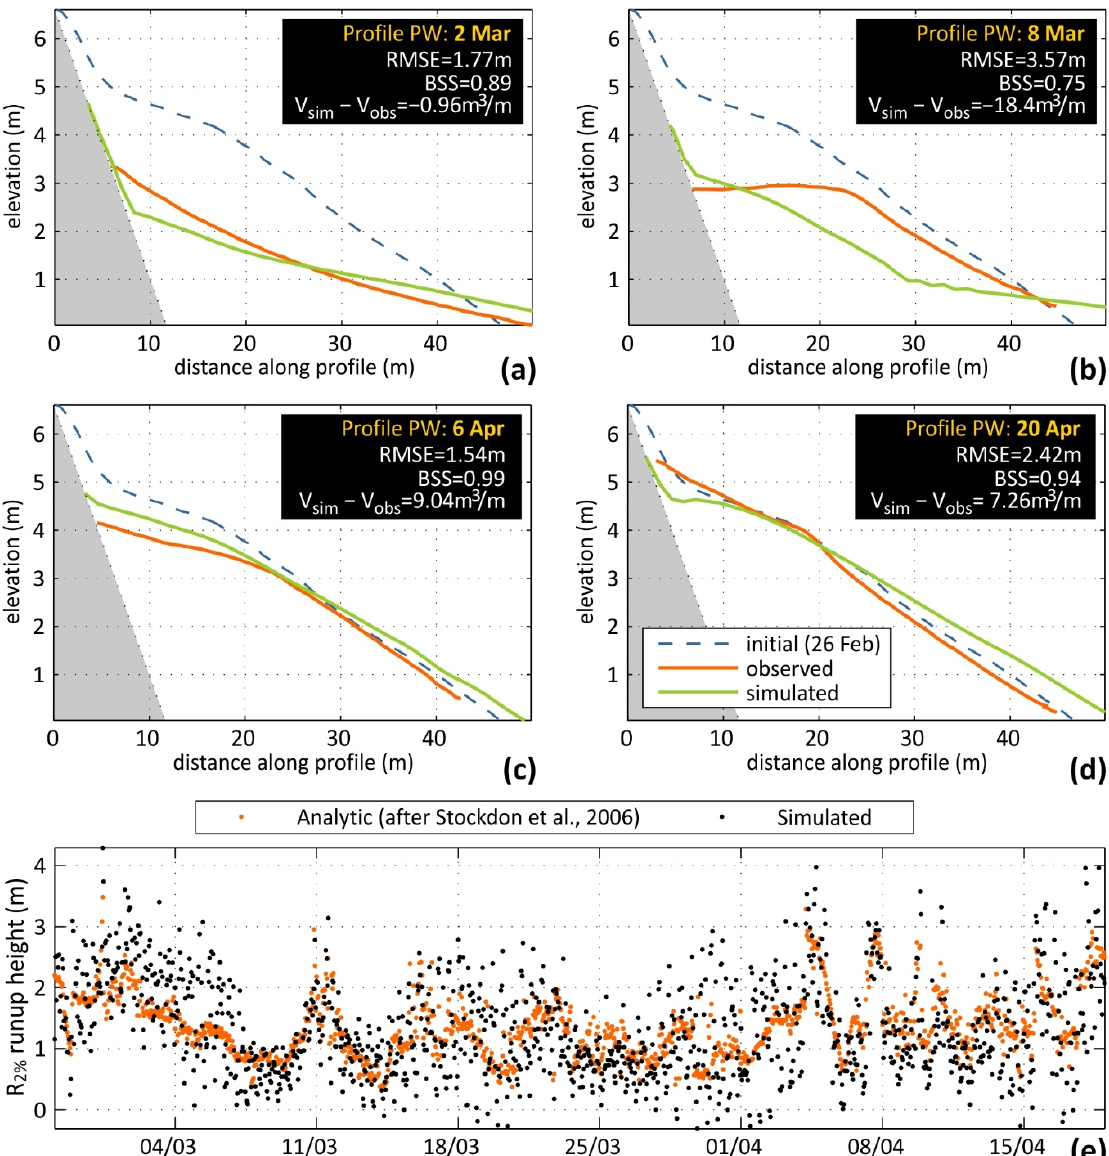
Figure 6. Calibration results for profile PW (see Figure 1 for location): ( a – d ) show the goodness of fit between simulated (green line) and observed (orange line) profiles for 2 and 8 March and 6 and 20 April, respectively (RMSE, BSS and total volume difference between simulation and observation (V sim − V obs ) are given in the legend); the time-series of theoretic (orange dots, after [46]) and simulated (black dots) R 2% runup heights are given in ( e ).